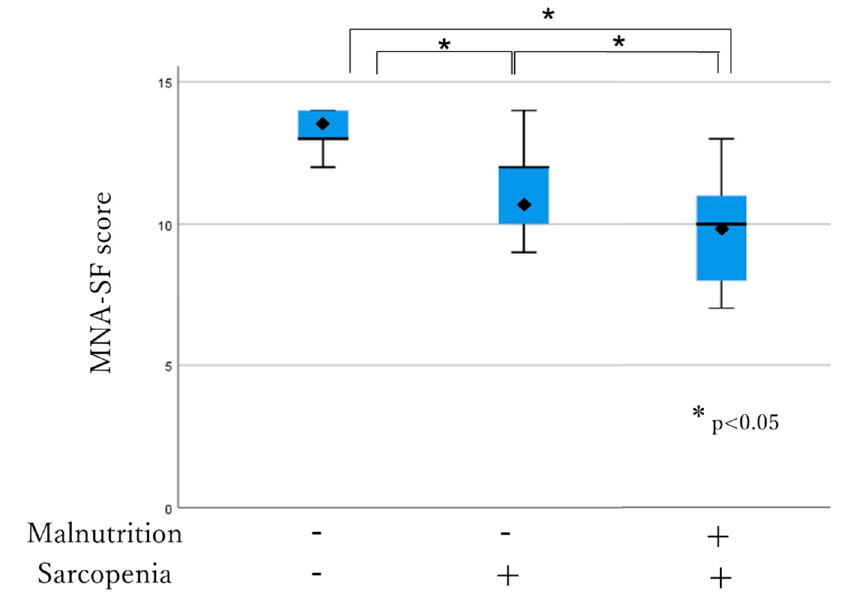
Figure 2. Subgroup association with MNA-SF.